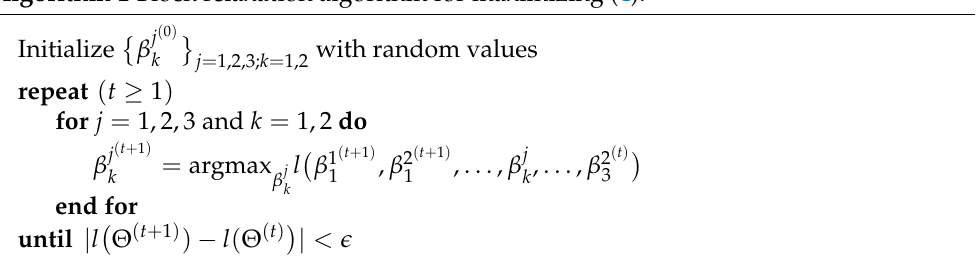
Algorithm 1 Block relaxation algorithm for maximizing (4).